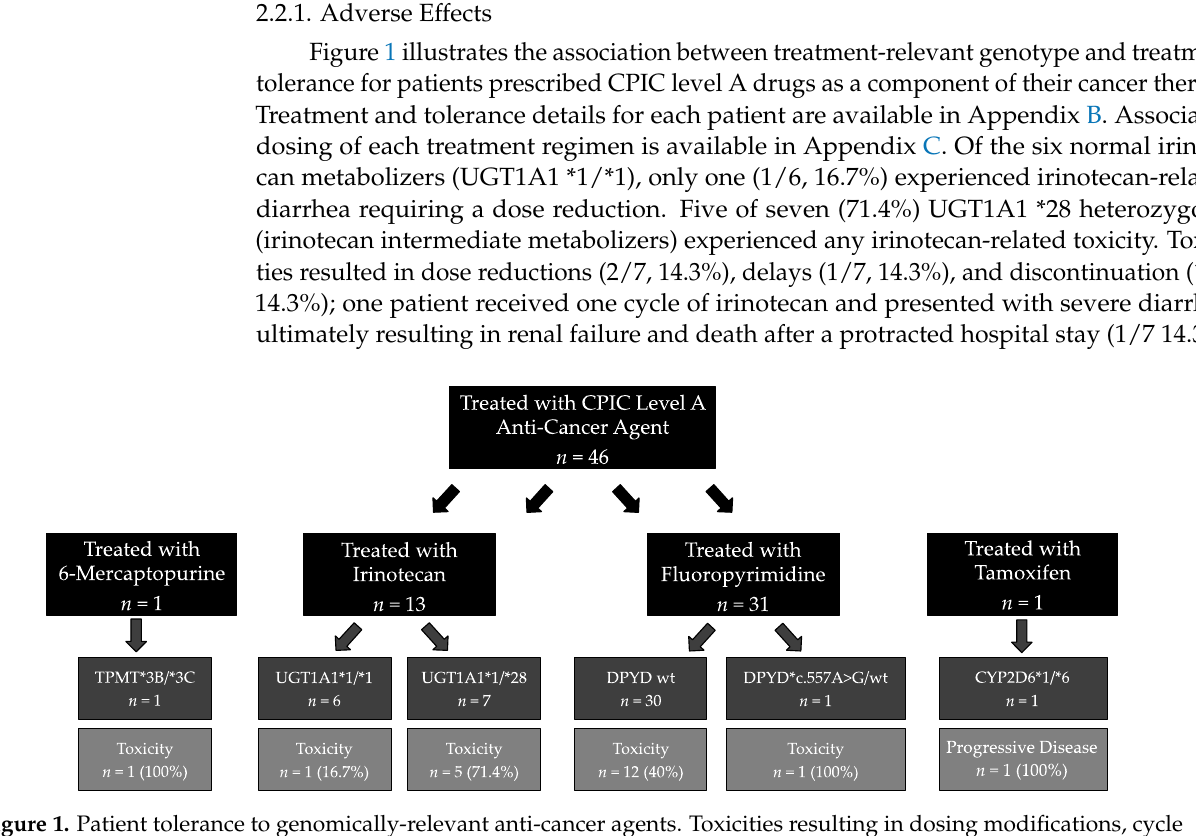
Figure 1. Patient tolerance to genomically-relevant anti-cancer agents. Toxicities resulting in dosing modifications, cycle delays, or discontinuation are reported. 6-mercaptopurine toxicity included cytopenia; irinotecan toxicities included cytopenia and diarrhea; fluoropyrimidine toxicities included cytopenia, diarrhea, hepatotoxicity, mucositis/stomatitis, and